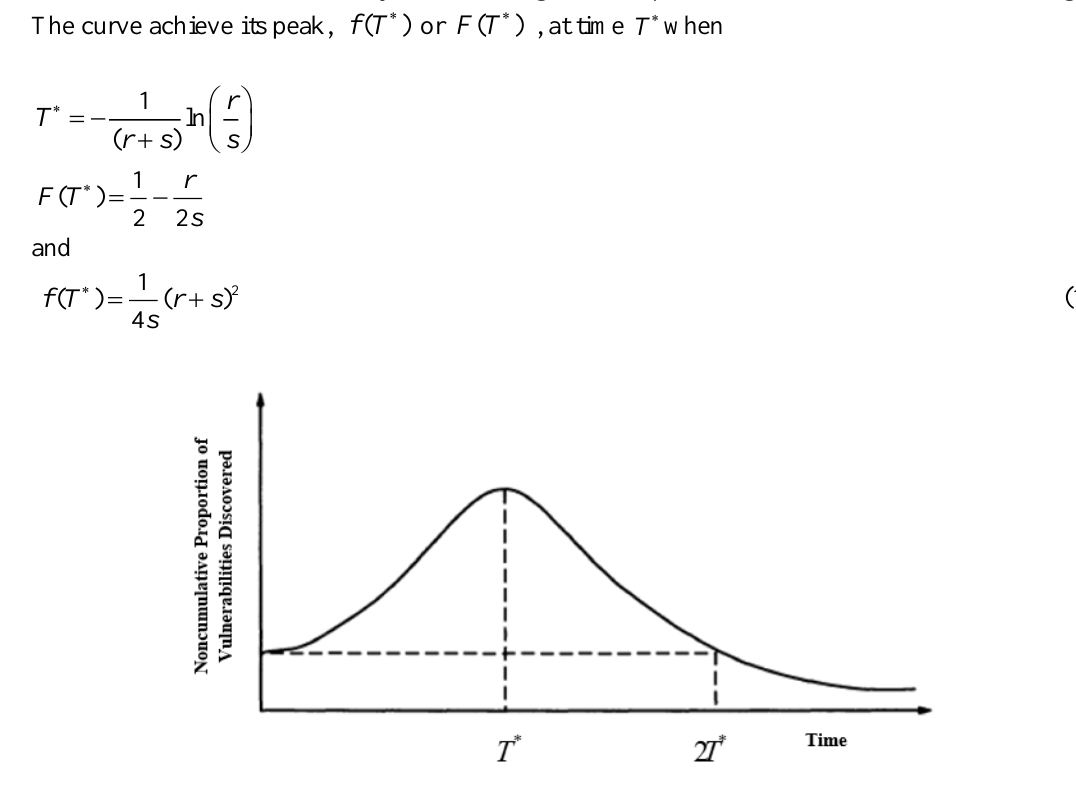
Fig. 1. Noncumulative vulnerabilities